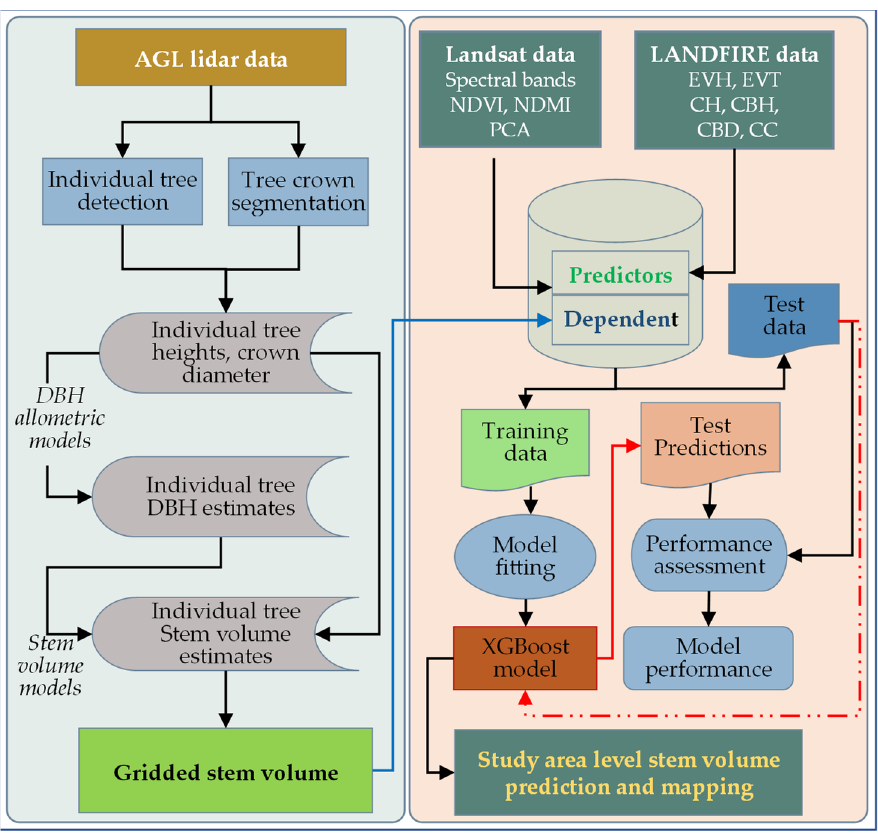
Figure 3. Overview of processing workflow showing main steps in generating reference stem volumes, preparation of Landsat and LANDFIRE predictors, and the stem volume regression modeling using the XGBoost library.